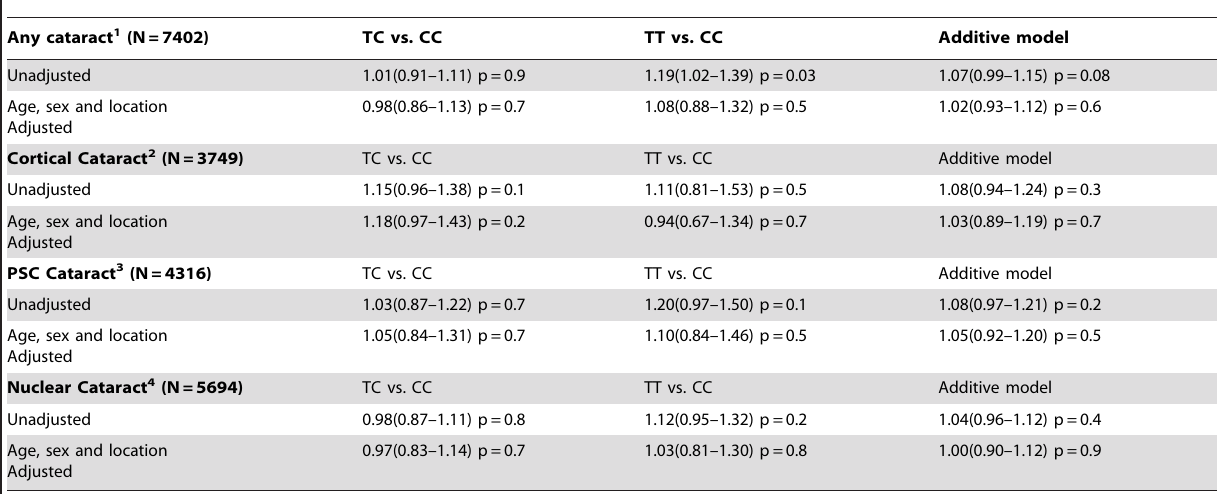
Table 3. Associations between cataract and rs3754334.